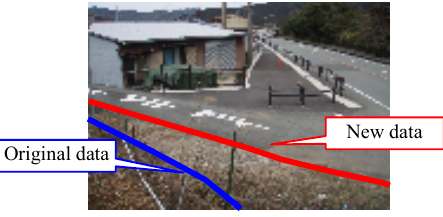
Figure 7. Difference in road boundaries